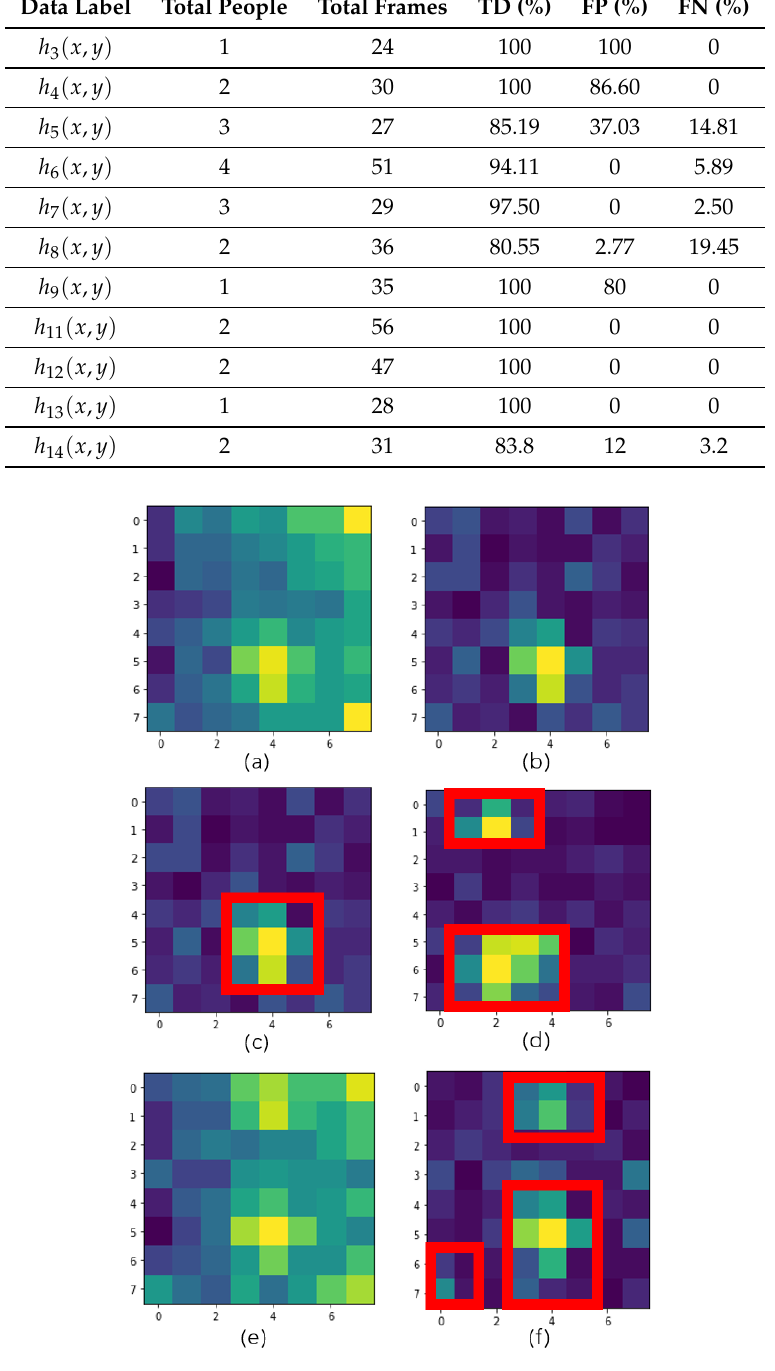
Figure 8. Analysis of the computer vision based method (workflow 1). ( a ) A raw image frame from h 13 ( x , y ) recording having one person in the scene. ( b ) Frame given in ( a ), after background noise compensation. ( c ) Occupancy detection result for the frame given in ( a ). ( d ) Occupancy prediction result of a frame from the h 12 ( x , y ) recording which has two people in the scene. ( e ) A raw frame from the h 14 ( x , y ) recording which again has two people in the scene but at different seats. ( f ) Occupancy prediction result of the frame given in ( e ), which, unfortunately, has a false positive due to the heated seat where a person was sitting